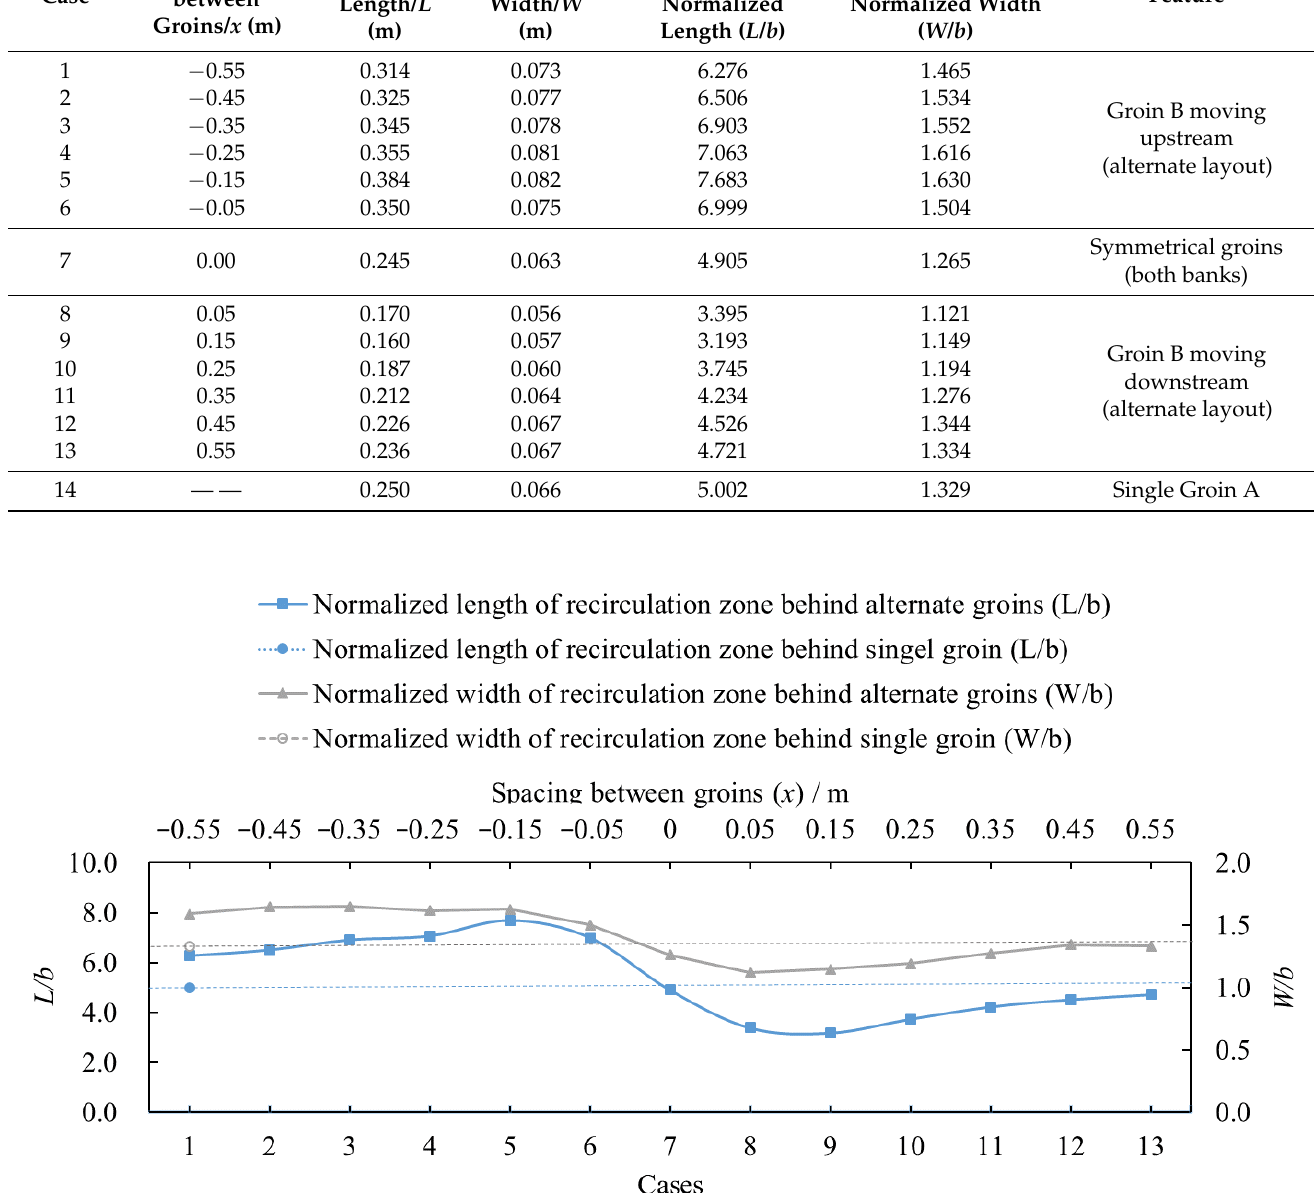
Table 1. Experimental results of the horizontal recirculation zone behind Groin A for different cases.